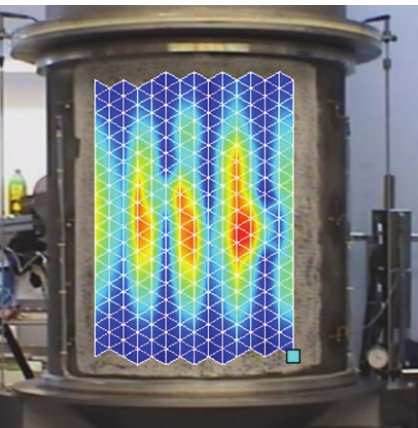
Figure 7: Fist vibration mode shape measured during testing (DLR- Z37).